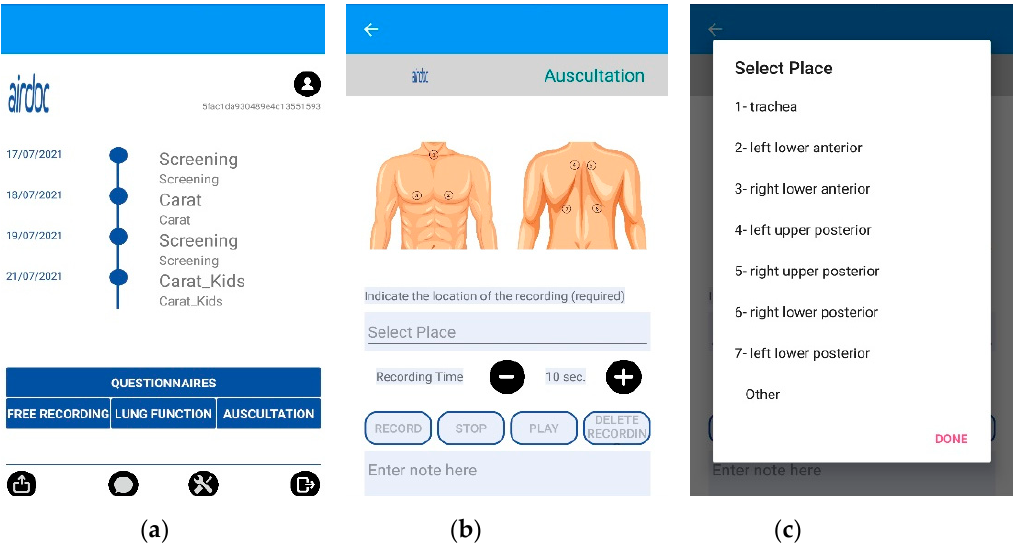
Figure 1. AIRDOC app screens used: ( a ) main screen; ( b ) lung auscultation feature; ( c ) location selection.